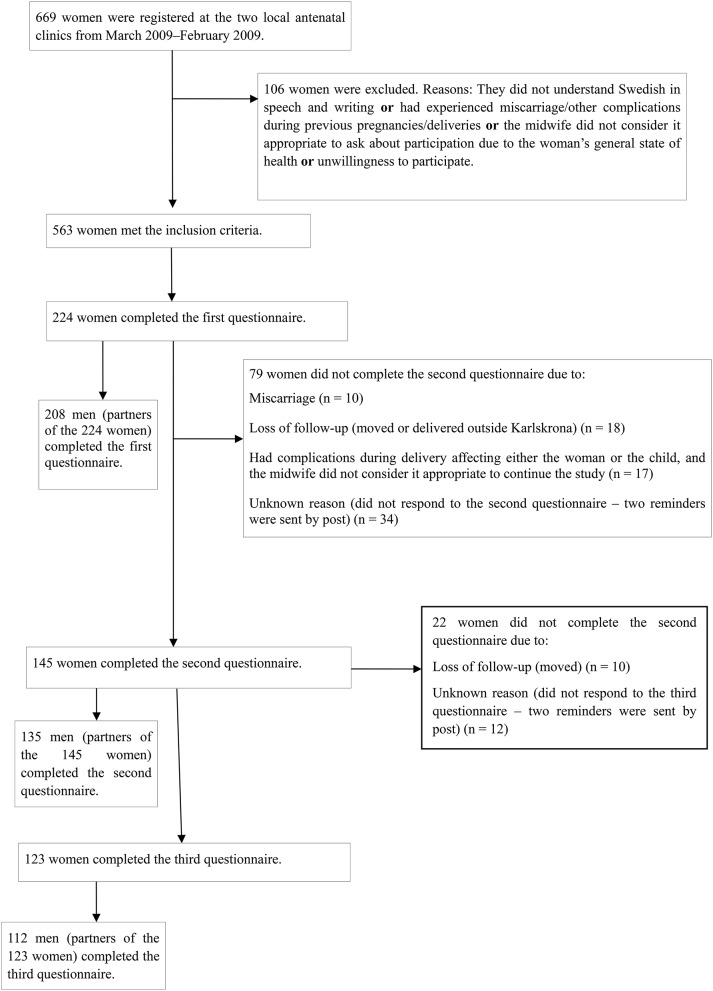
Flow figure chart.